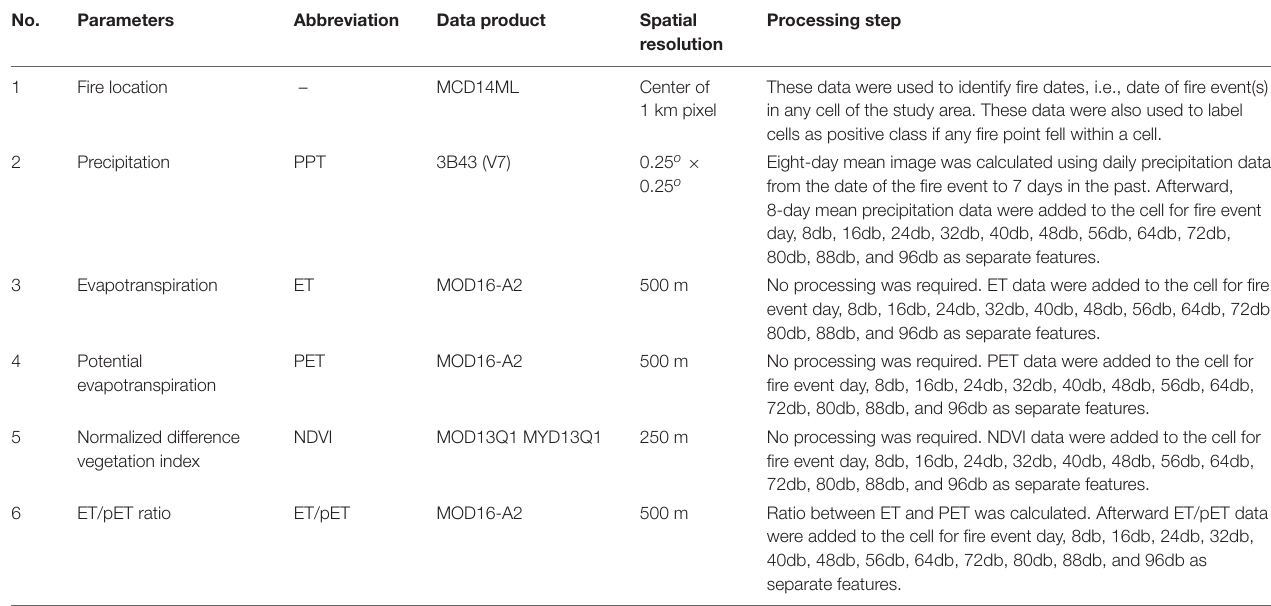
TABLE 1 | Features used for fire risk classification model and processing